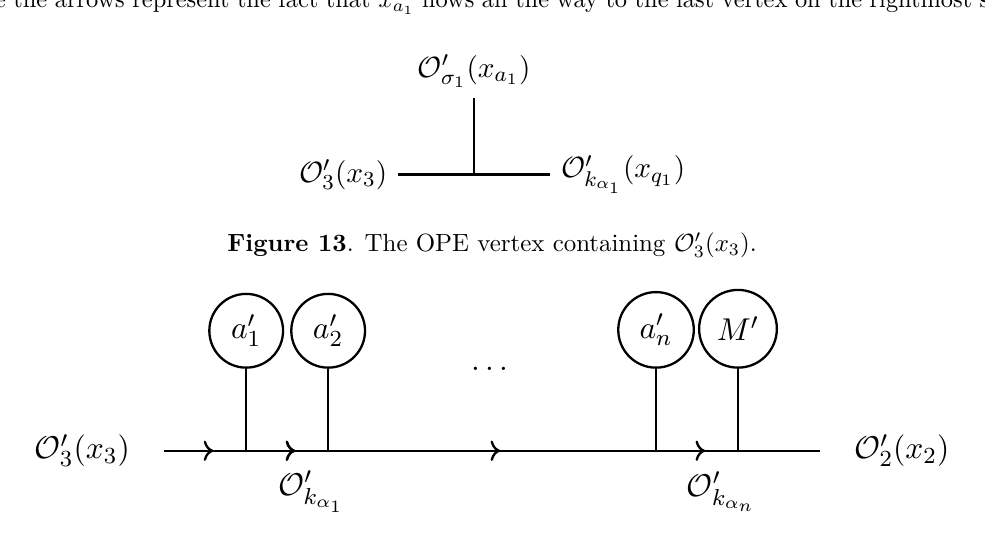
Figure 12 . The diagram that defines the cross ratios in (5.52) (left) and the OPE vertex (right). Here the arrows represent the fact that x flows all the way to the last vertex on the rightmost side. a 1